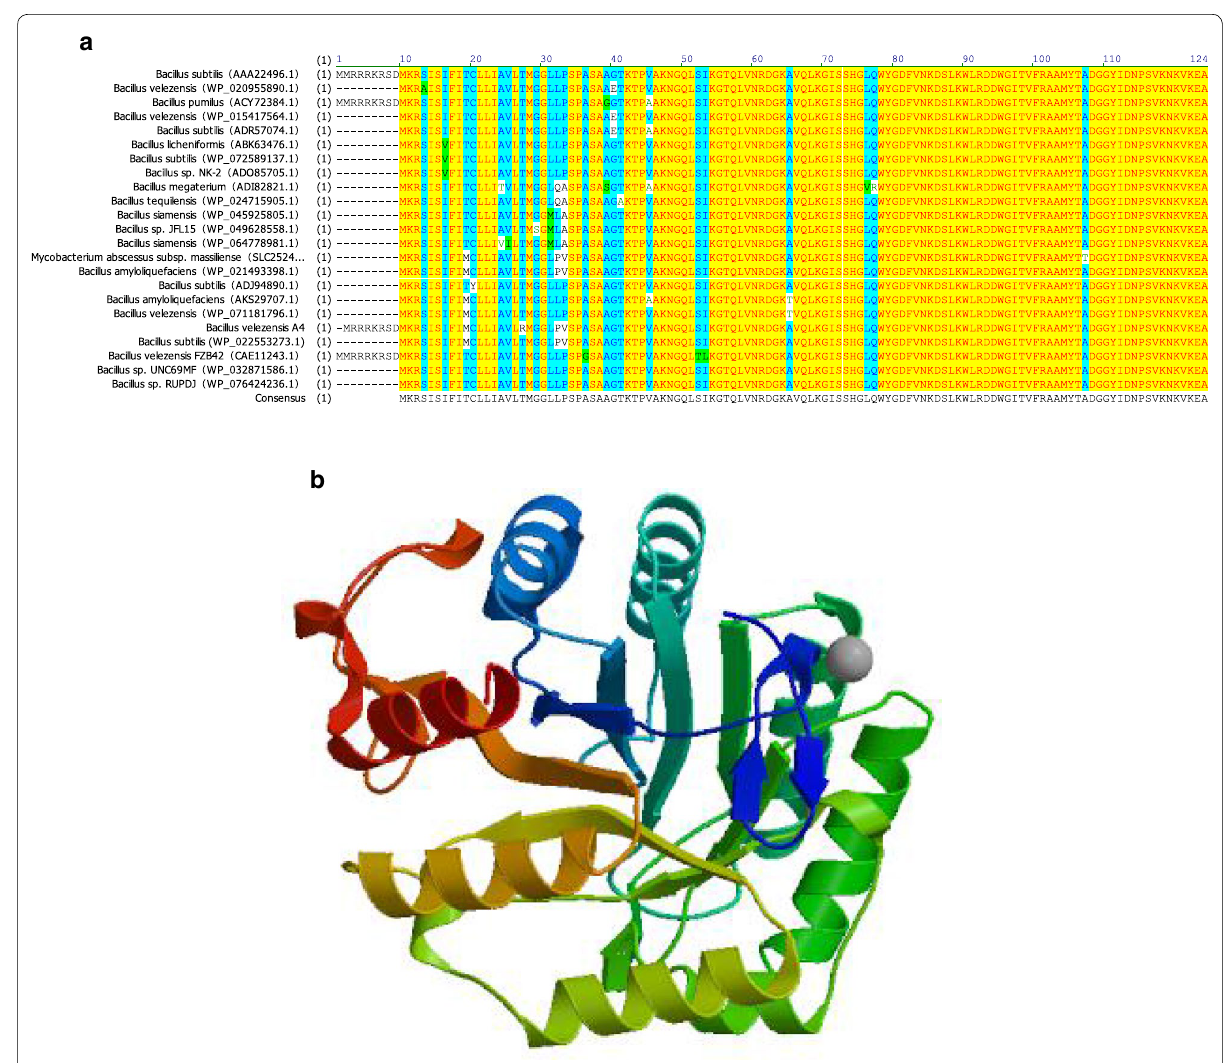
Fig. 4 a Multiple sequence alignment of endoglucanase (Egls) amino acid sequence with endoglucanase from other Bacillus strains. Note: There are 5 different amino acids in the front of Egls from B. velezensis A4; b homology model of Egls using predicted amino acid as template, which con- sists of α-helixes, β-strands, random coils, Mg 2 + binding site (grew